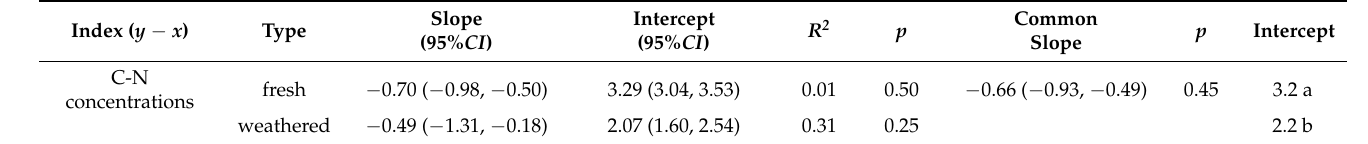
Figure 4. The effect size of rock C, N, and P concentrations, and stoichiometry response to weathering (Error bars represent ± 95% CI).